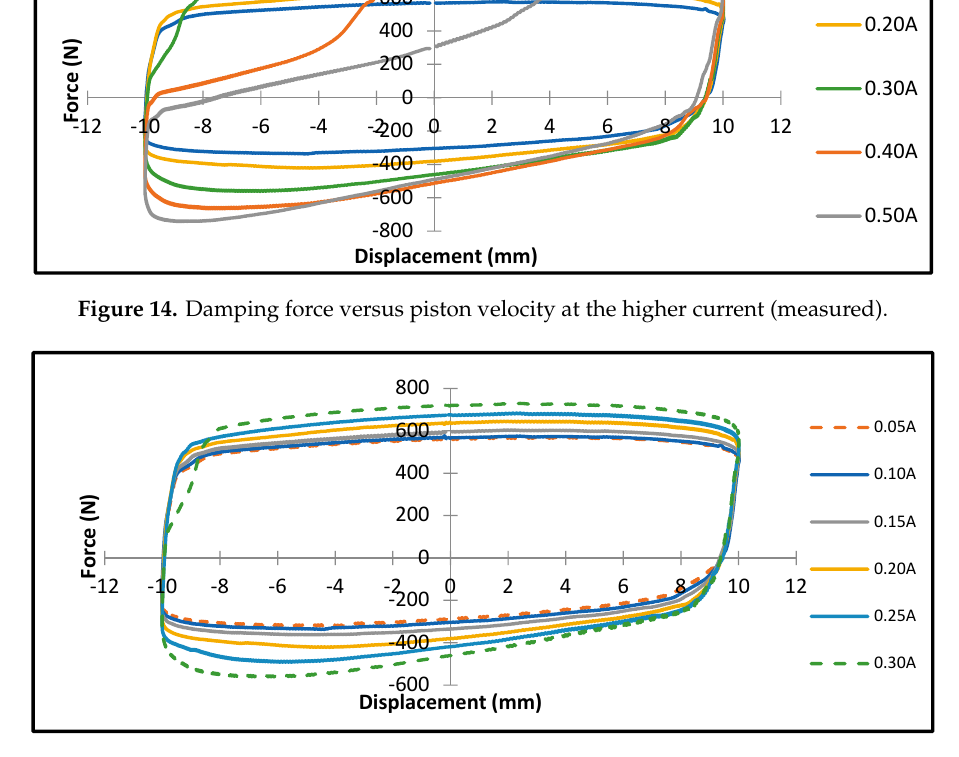
Figure 15. Damping force versus piston displacement (measured).